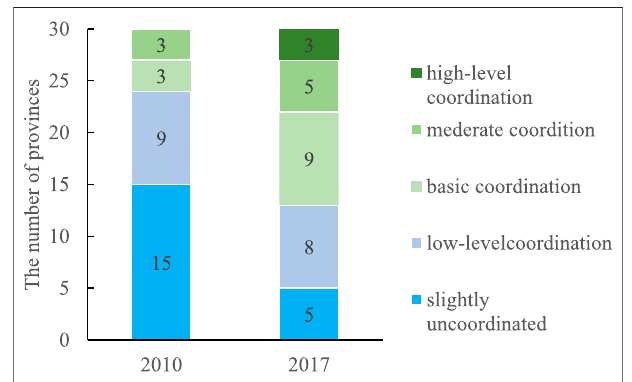
FIGURE 7 | The number of provinces in different coupling coordination stages.